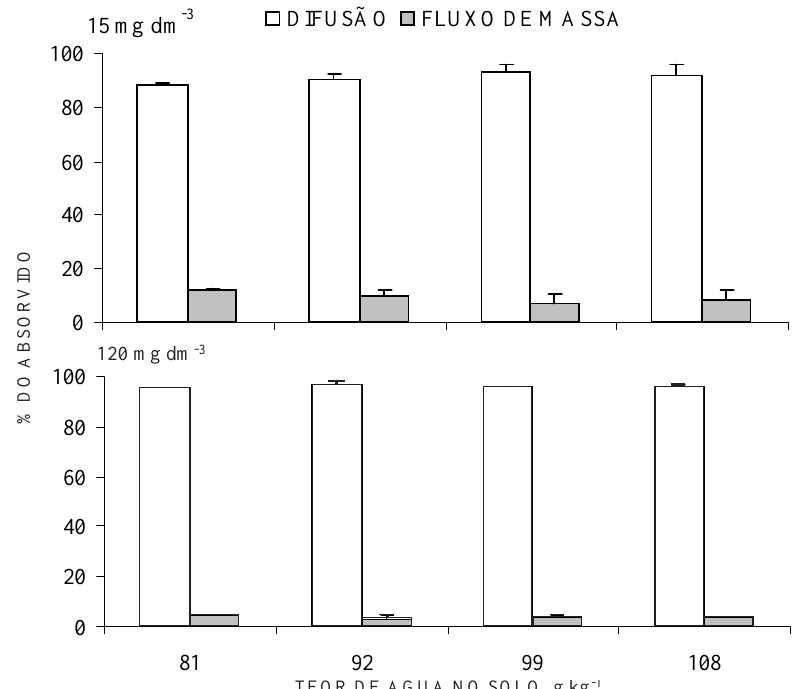
TEOR DE ÁGUA NO SOLO, g kg Figura 1. Contribuição relativa dos mecanismos de difusão e fluxo de massa no suprimento de potássio às raízes de milheto (28 DAE), considerando os teores de água no solo, correspondentes aos potenciais testados, e as doses de potássio. As barras no topo das colunas representam o desvio-padrão da média.